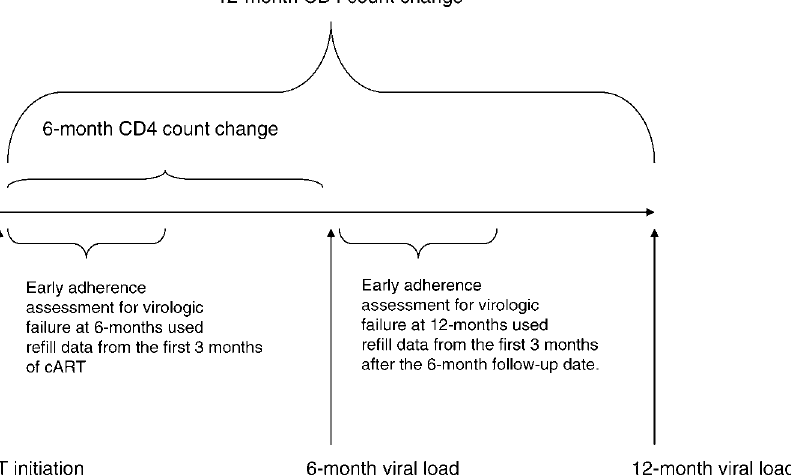
Figure 1. Schematic Illustrating Intervals during Which Pharmacy Refill Data Were Assessed as Early Markers of Subsequent Virologic Failure Adherence in the first 3 mo of cART was compared with the CD4 count change from cART initiation to the time of the 6-mo viral load. Adherence in the first 3 mo after the 6-mo follow-up date was compared with the CD4 count change measured from baseline to the time of the 12-mo viral